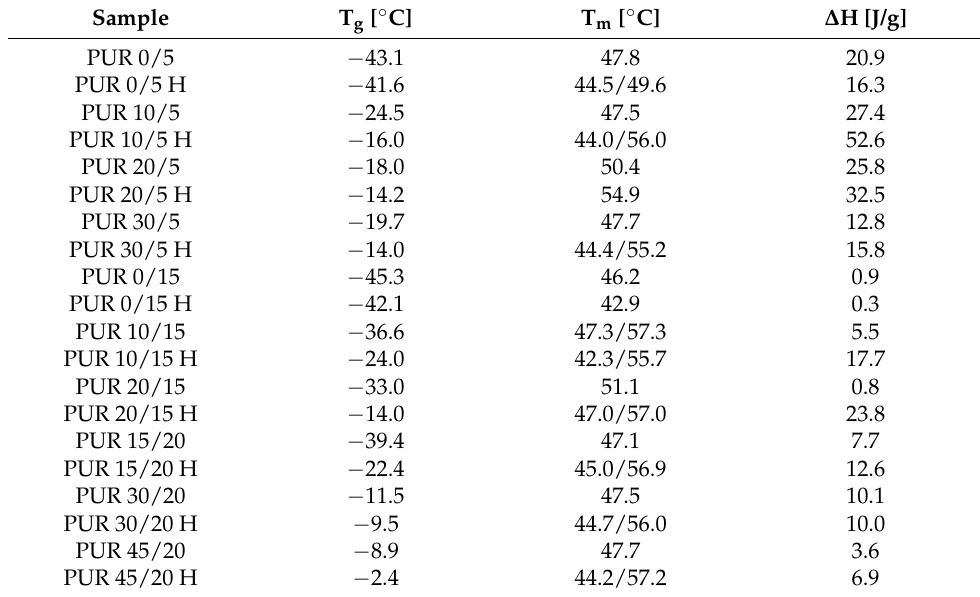
Table 4. Thermal properties of PURs before and after incubation in the buffer